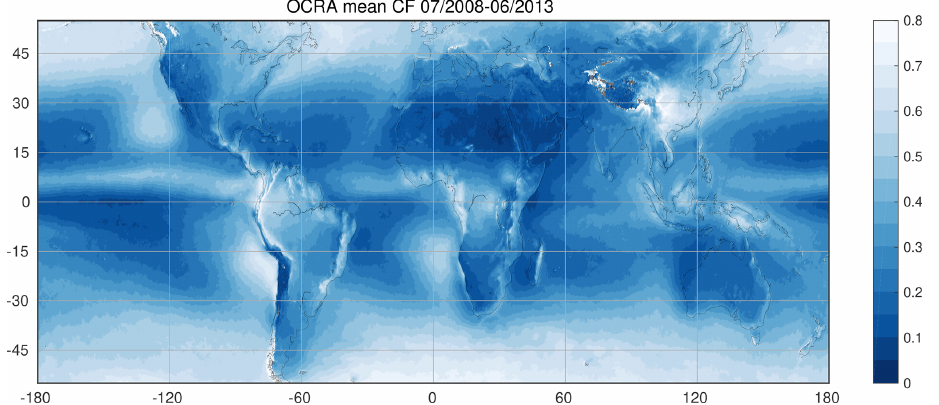
Figure F9. Same as Fig. 14 but showing the 5-year average of the OCRA cloud fraction measurements recorded between 1 July 2008 and 30 June 2013. Areas without data are plotted in